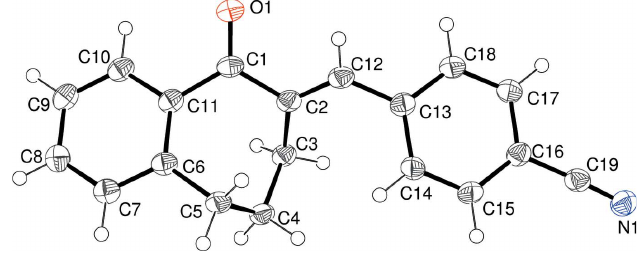
Figure 5 The molecular structure of (V), showing 50% probability displacement ellipsoids.